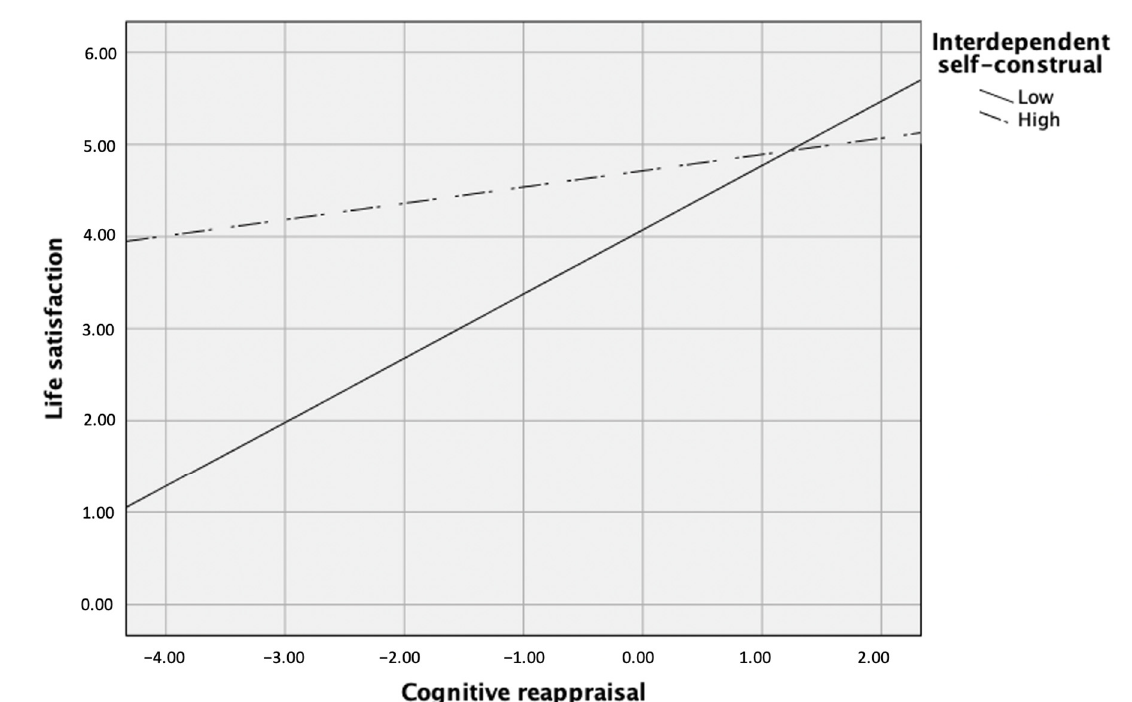
Figure 3. Interdependent self-construal as a moderator between cognitive reappraisal and life satisfaction. As for the link between expressive suppression and life satisfaction, the post hoc sim- ple slopes test showed that the relation between expressive suppression and life satisfac- tion was significantly negative when interdependent self-construal was high (i.e., 1 SD above the mean), β = − 0.27, p = 0.003, but not significant when it was low (i.e., 1 SD below the mean), p > 0.05 (see Figure 4).